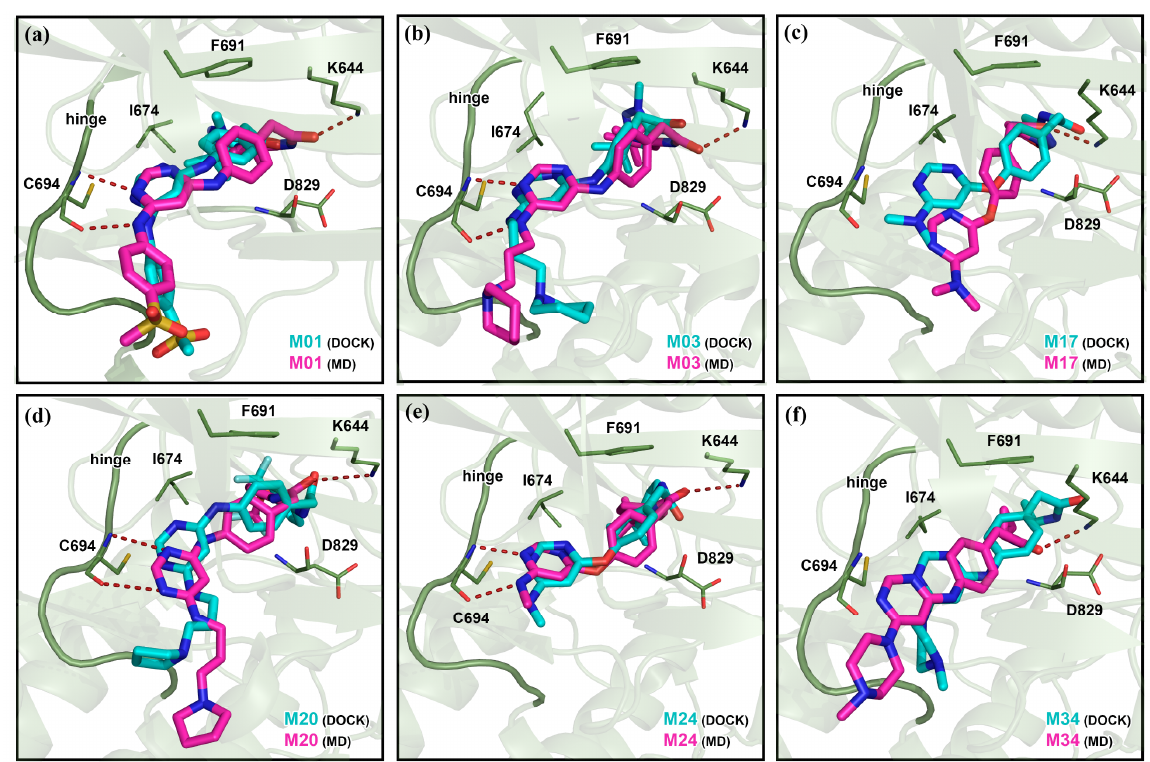
Figure 5. Average MD pose of the ligand at the active site of FLT3. The last 1 ns average MD poses of ( a ) M01, ( b ) M03, ( c ) M17, ( d ) M20, ( e ) M24, and ( f ) M34 inside the binding pocket are shown in pink color. The corresponding docked pose is shown in cyan color. The H-bond interactions are shown by red dashed lines.